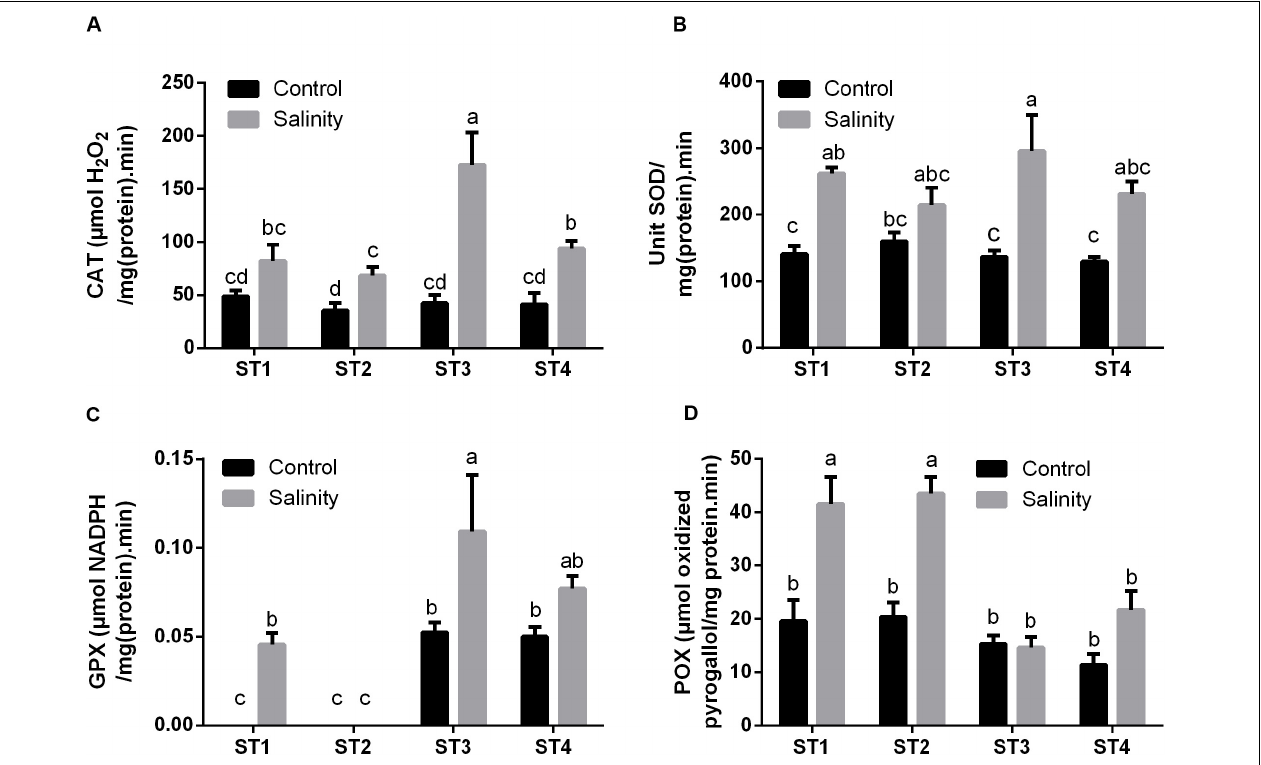
FIGURE 6 | The antioxidant enzyme activities that directly scavenge ROS of four salt-tolerant bacterial isolates (ST1, ST2, ST3, and ST4) including (A) CAT, (B) SOD, (C) GPX, and (D) POX under control and salinity stress conditions. Data are represented by the mean of at least three replicates, and error bars represent the standard error. Different small letters (a, b, c ... ) above bars indicate significant differences between means at p < 0.05.